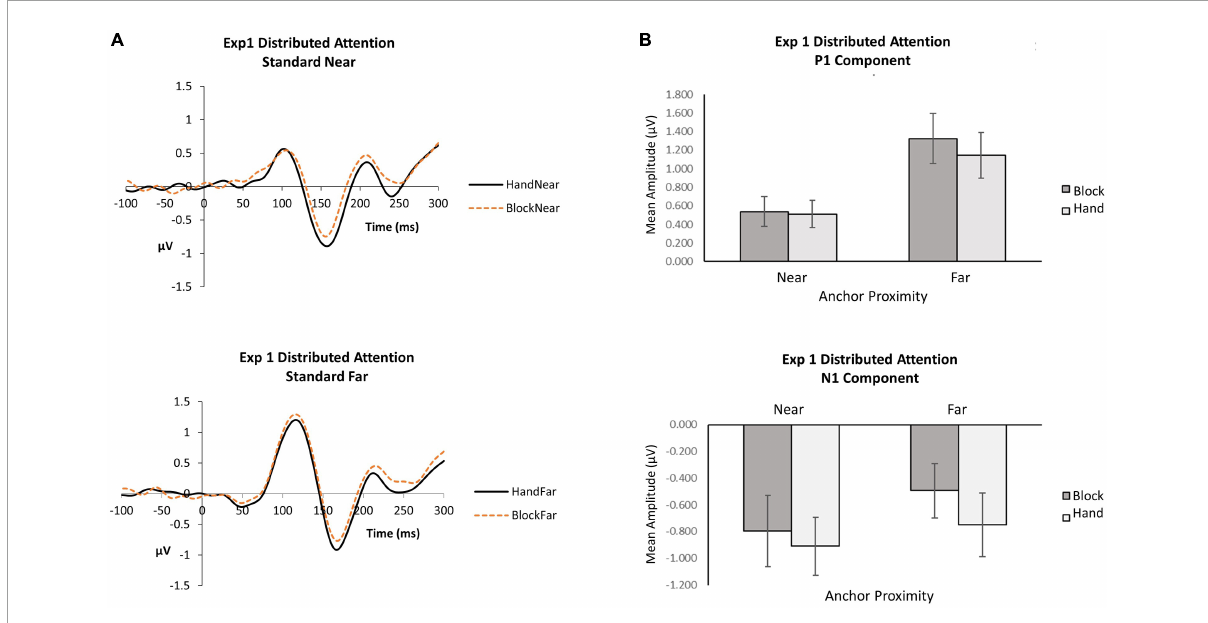
FIGURE2 Experiment 1 distributed attention. (A) Grand average waveforms for hand and block conditions in near and far locations. (B) P1 and N1 mean amplitudes by anchor type and anchor